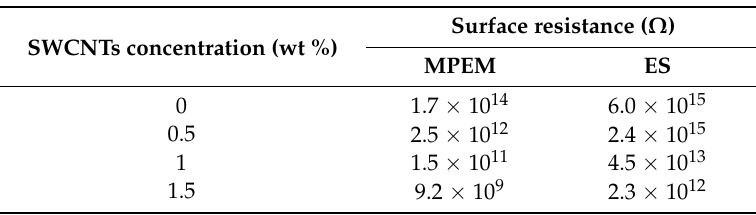
Table 3. Surface resistances of random and aligned SWCNTs/PAN nanofiber membranes with the different content of